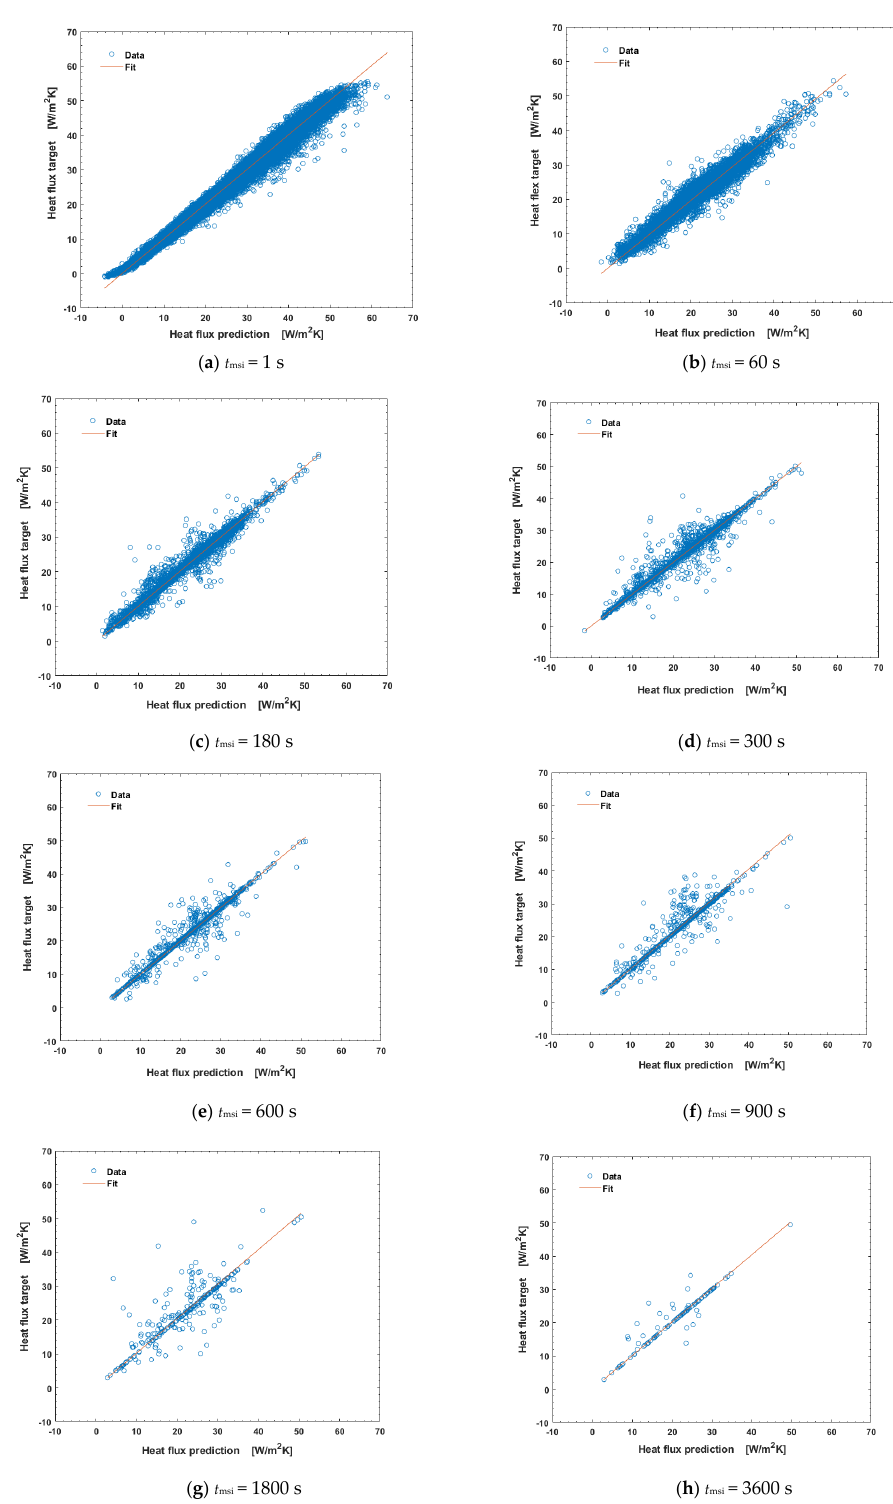
Figure 6. Error histogram for all data using LSTM model.